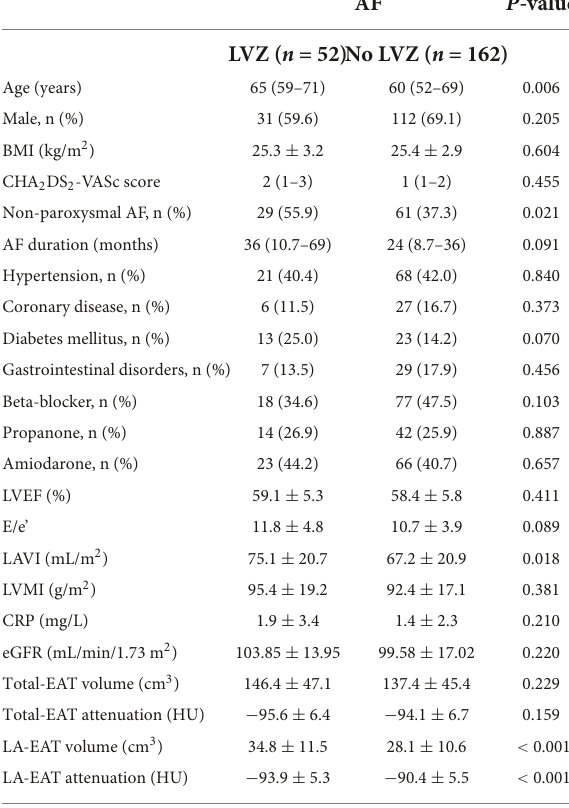
TABLE 1 Demographics and baseline characteristics: controls and patients with atrial fibrillation.